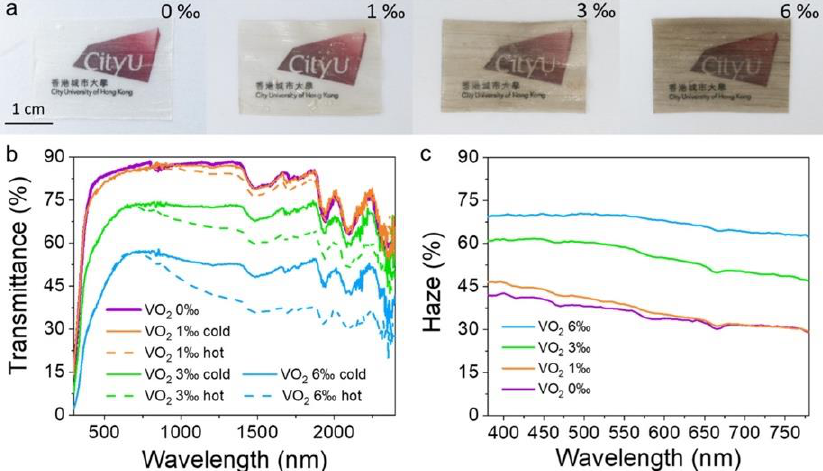
Figure 17. ( a ) Thermochromic transparent wood film (TTWF) with different concentrations of W- doped VO 2 (0, 1, 3, and 6‰ from left to right); ( b ) temperature-dependent optical transmittance spectra of VO 2 -TTWF; and ( c ) optical transmittance haze of VO 2 -TTWF. VO 2 X‰ cold and hot refer to transmittance measured after thermal switching from cold to hot state. Reprinted with permission from [39], copyright 2021, American Chemical Society.